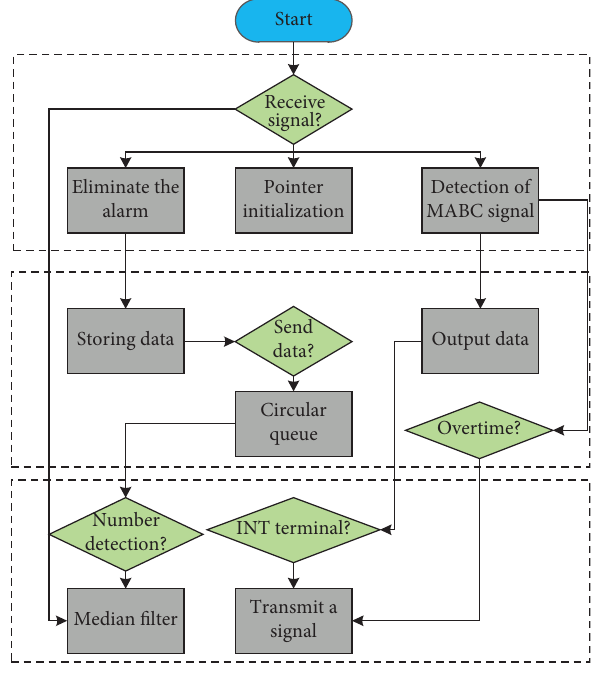
Figure 1: Algorithm flow of 3D human tracking